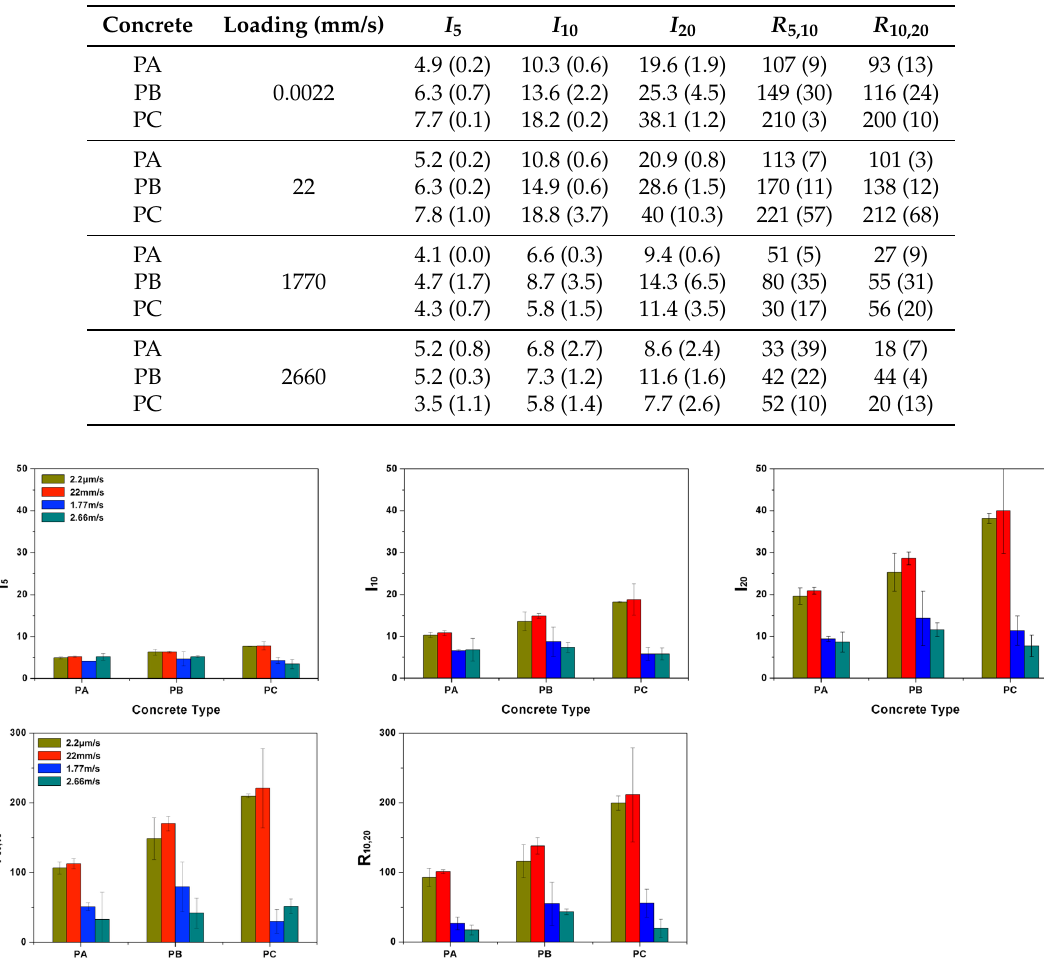
Table 5. The measured toughness indices and residual strength factors with their corresponding standard deviations in the parentheses for the three types of concrete at four different loading rates.